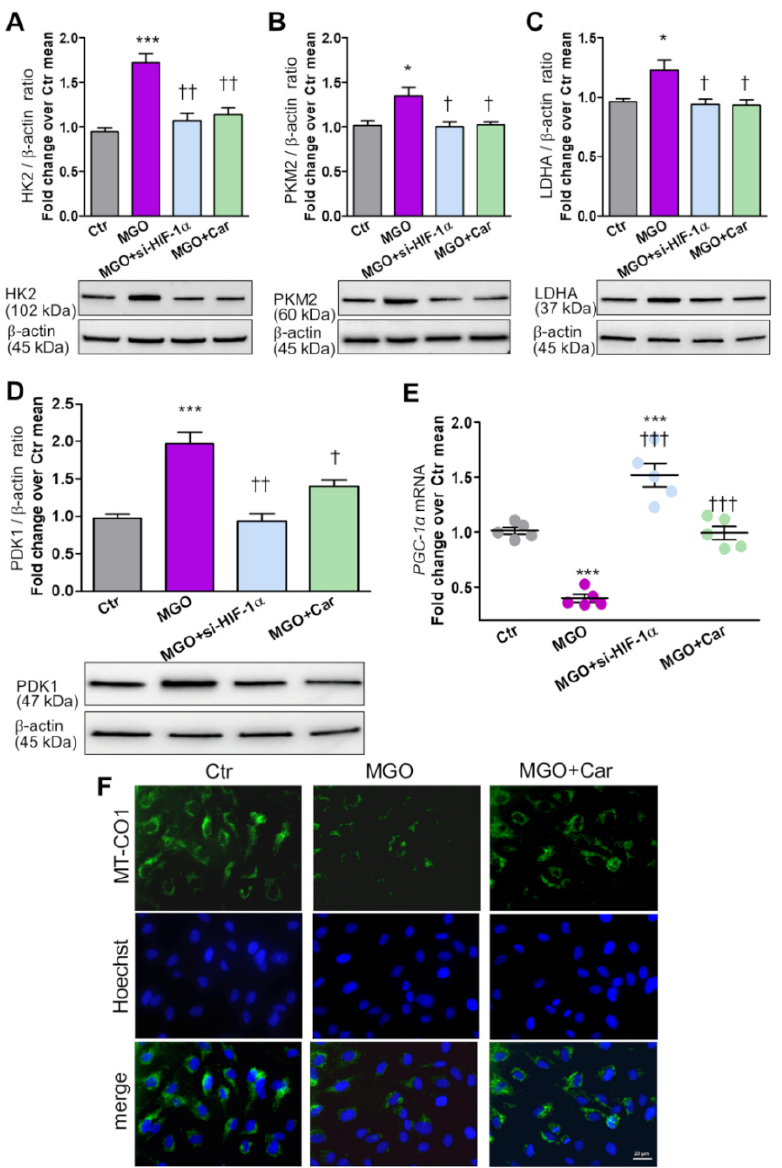
Figure 5. The glycolytic side-product MGO modulates HIF-1 α target genes related to cellular glucose metabolism. Western blot analysis of the glycolytic enzymes HK2 ( A ), PKM2 ( B ) and LDHA ( C ), and of the inhibitor of pyruvate dehydrogenase activity PDK1 ( D ) in total cell extracts from HUVEC treated (or untreated, Ctr = control) with the reactive dicarbonyl compound MGO (200 µM) for 48 h, silenced for HIF-1 α (si- HIF-1 α ), or in the presence of the carbonyl trapping agent Car (20 mM), and relative band densitometry analysis from three separate experiments. mRNA levels of the mitochondrial biogenesis marker PGC-1 α ( E ) in HUVEC exposed to MGO for 48 h, silenced for HIF-1 α , or treated with Car; each dot represents the mean of two technical replicates of 5 wells per condition. Representative IF ( F , scale bar 20 µm) for MT-CO1 in HUVEC treated or untreated (Ctr) with MGO for 48 h, in the presence or absence of Car. Bars represent mean ± SEM. Post hoc multiple comparison: *** p < 0.001 or * p < 0.05 vs. Ctr; ††† p < 0.001, †† p < 0.01 or † p < 0.05 vs. MGO.